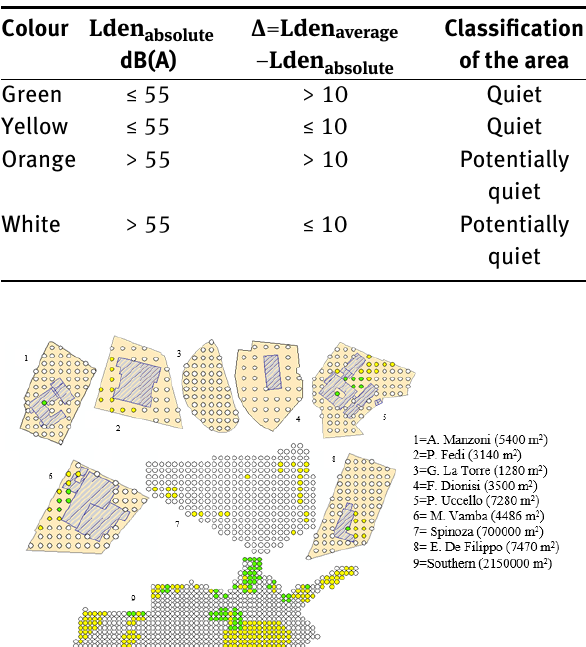
Table 3: Classification of areas according to the rQUA method.